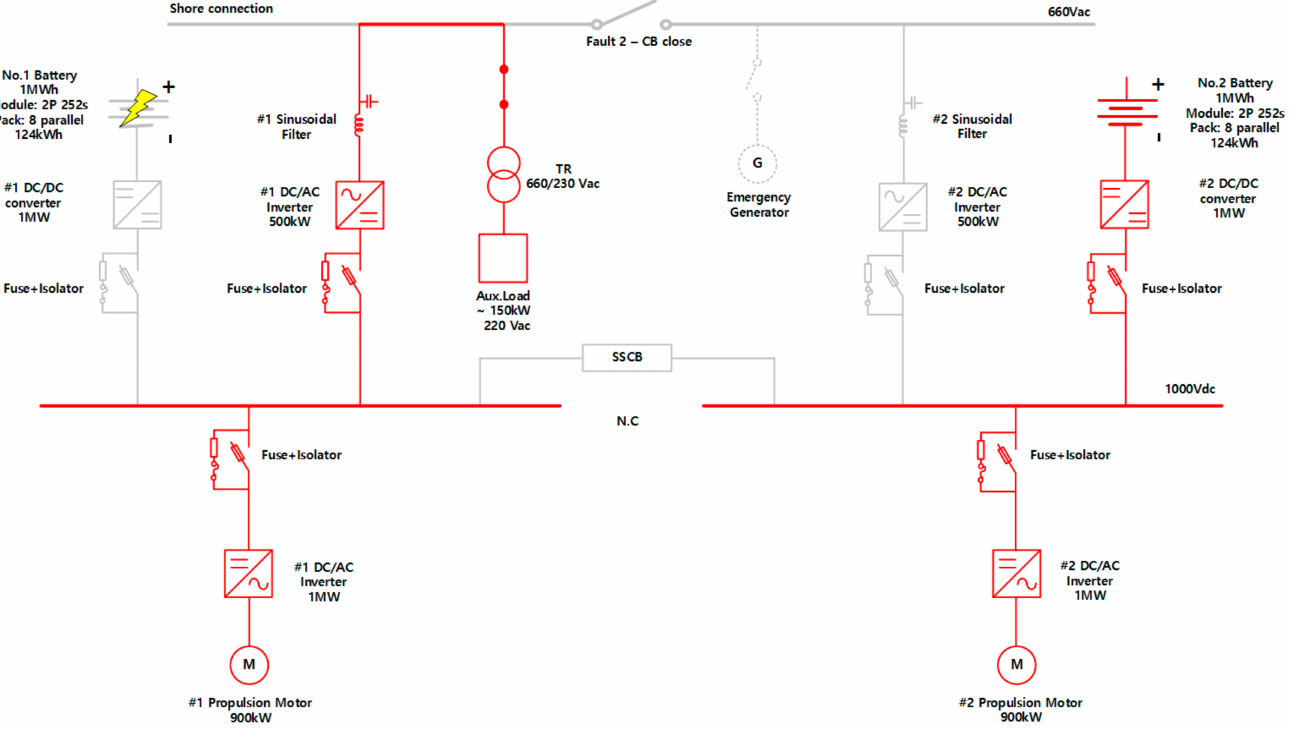
Figure 13. Schematic diagram of the discharge reflecting battery accident situation—Fault 2. Figure 14 shows the DC distribution structure, where two 1 MW DC/DC converters connected to the 1 MWh batteries were removed. The 1 MW DC/DC converter used for voltage balance at the DC bus terminal was removed by separating the two batteries by N.O (Normally Open) operating the DC Bus Tie. In this case, in the event of a